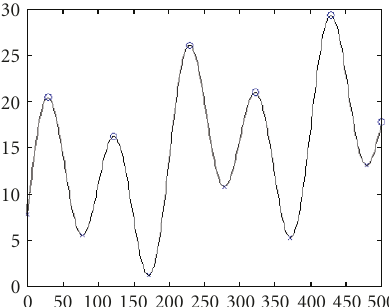
Figure 6: A 1D signal and its local maxima and minima